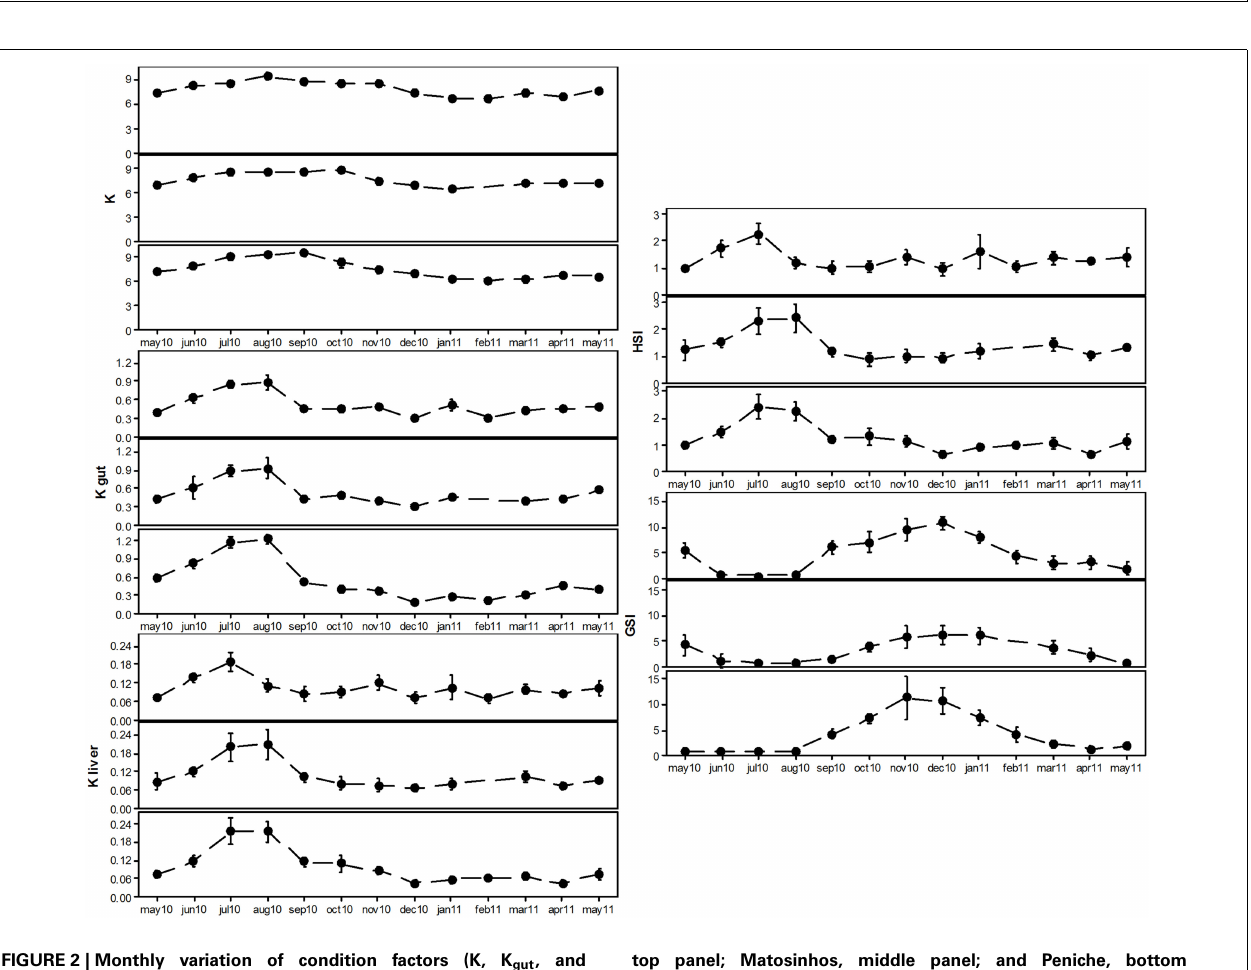
FIGURE 1 | PCA biplots of fish scores of three subpopulations of Sardina pilchardus (Aveiro, Matosinhos and Peniche), illustrating their variation according to physiological (condition) and reproductive state (A) and